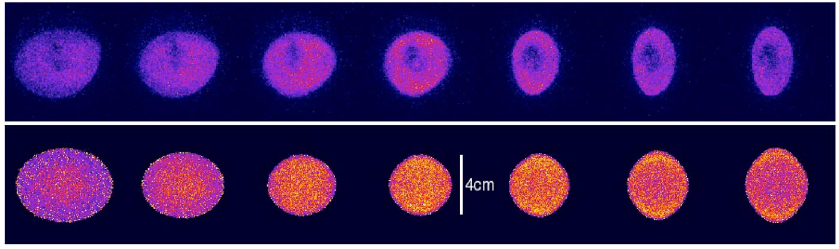
FIG. 38. (Color) Experimental (top row) and theoretical (bottom row) NTX beam profiles for a non-neutralized beam 1 m downstream from the exit of the final-focus system.